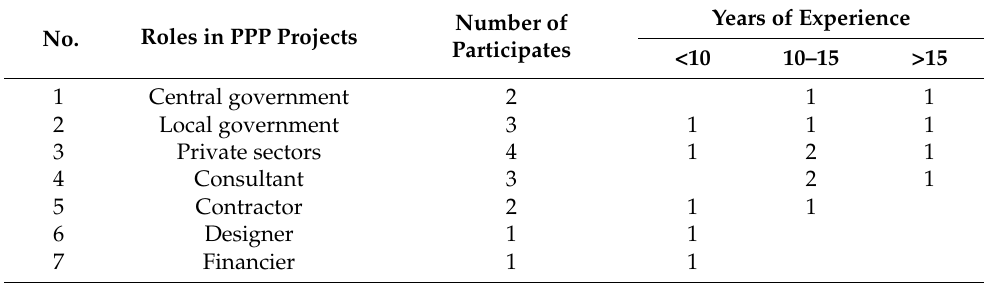
Table 3. Profiles of the experts.